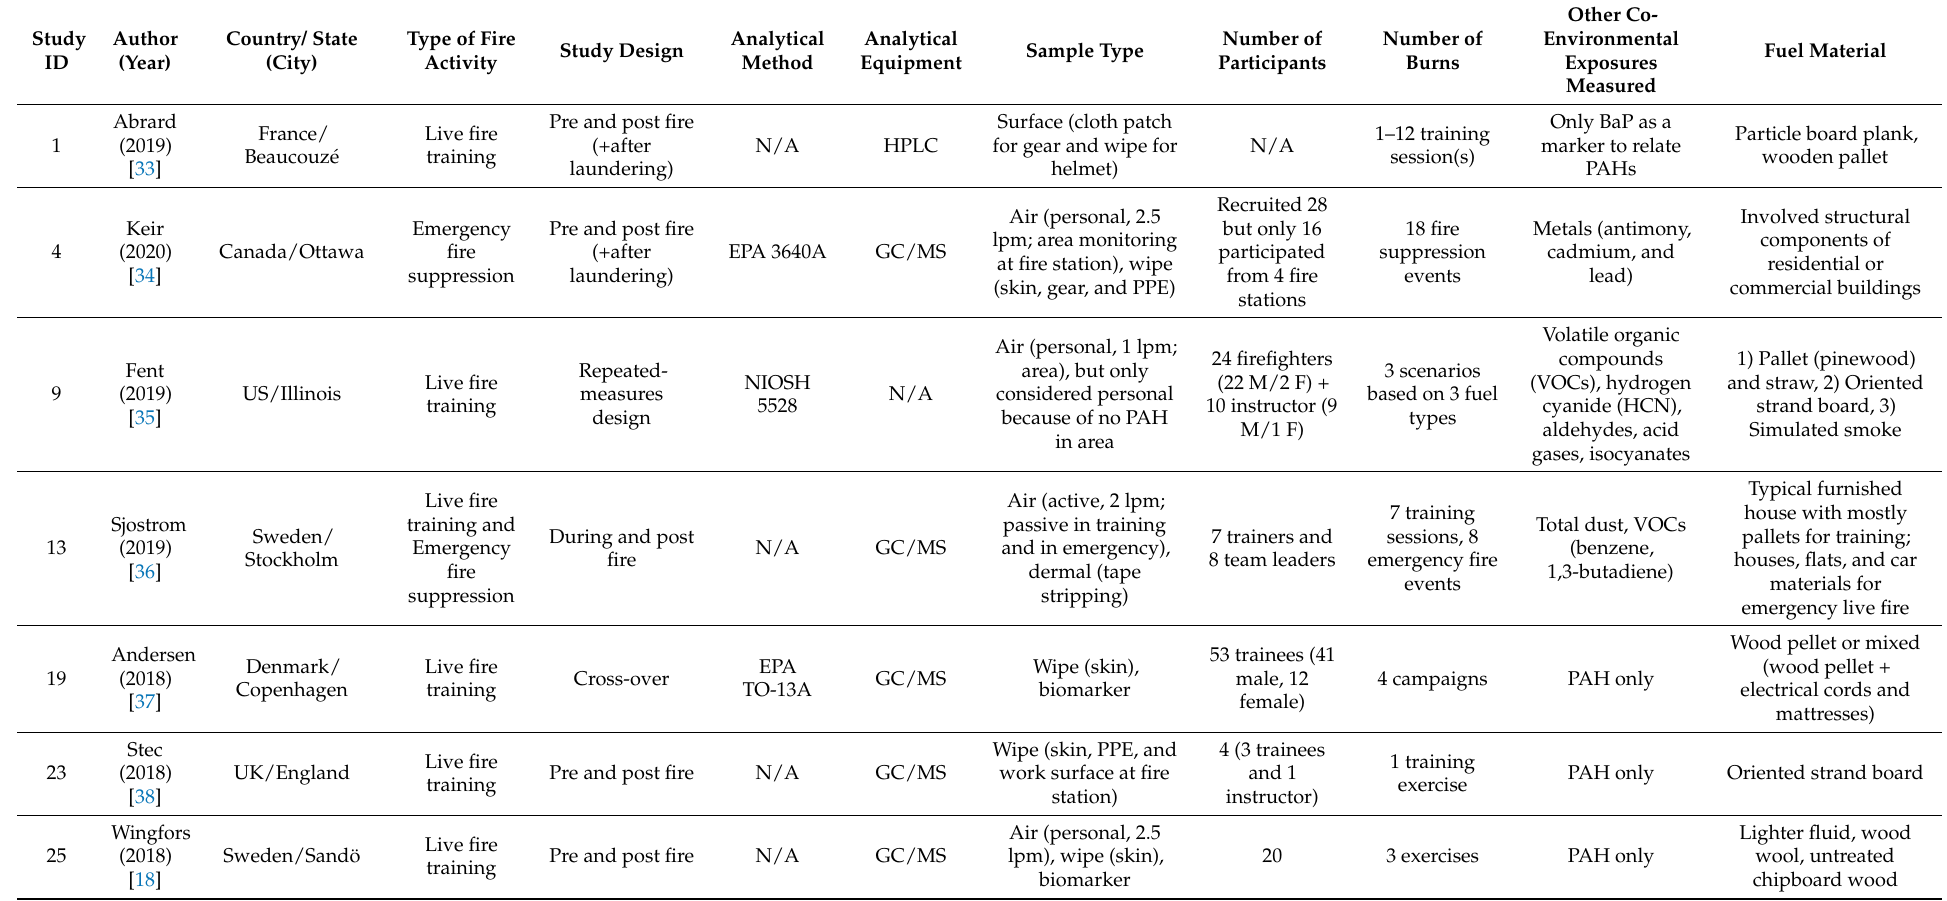
Table 1. Descriptive characteristics of the selected articles on environmental exposure to polycyclic aromatic hydrocarbons